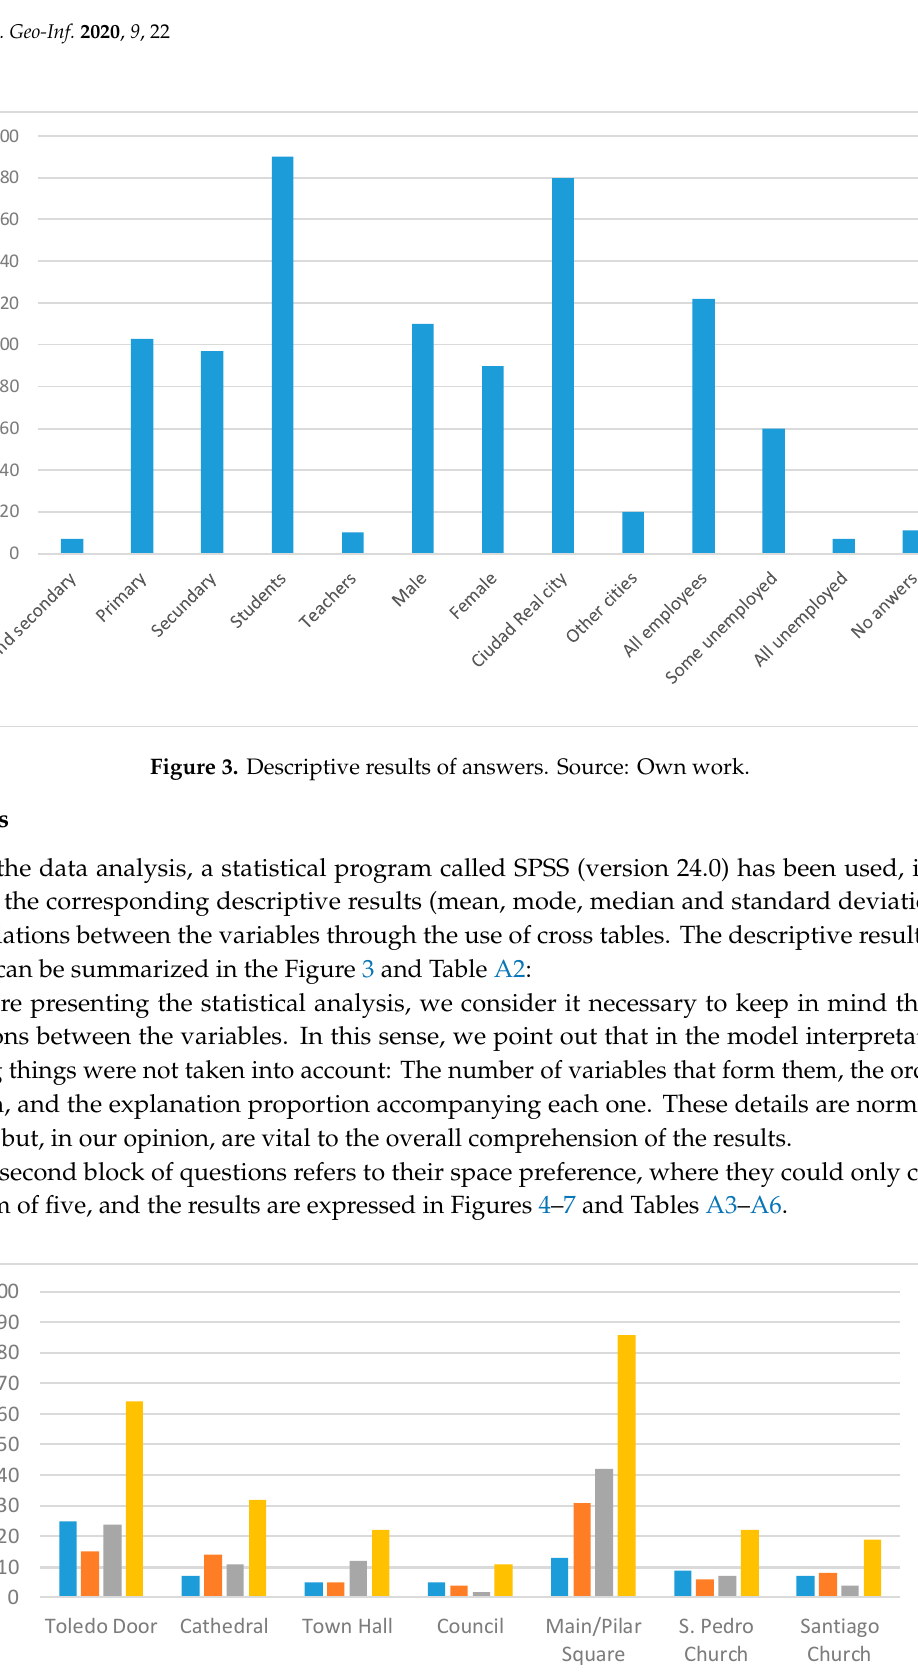
Figure 4. Results of answers relating to cultural heritage. Source: Own work.